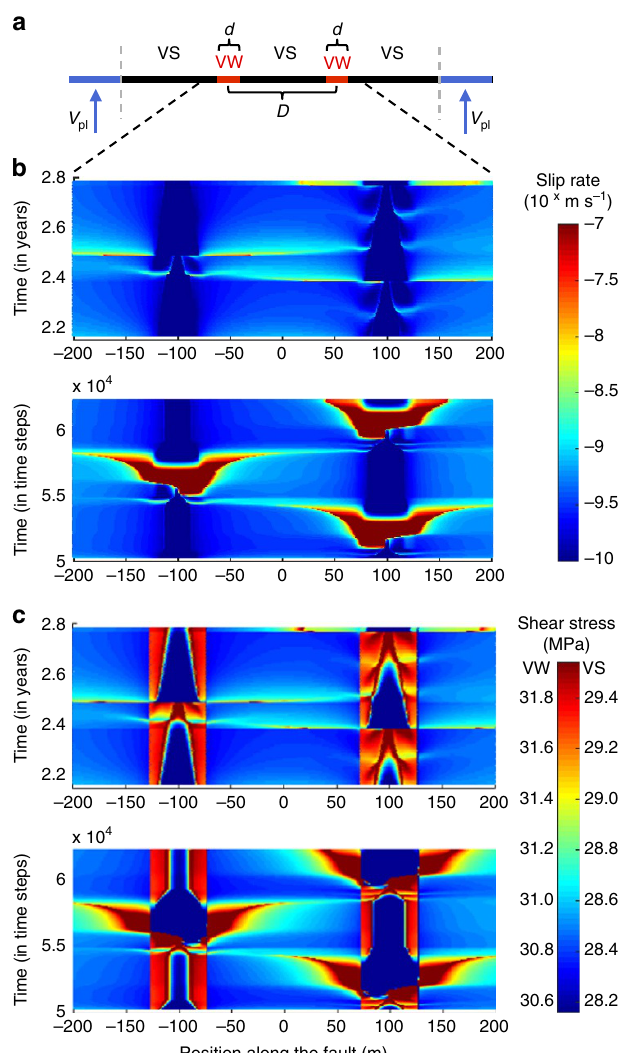
Figure 1 | Interaction of two repeating earthquake sequences in a rate- and-state fault model. ( a ) Schematics of the model in which a one- dimensional fault is embedded into elastic medium and loaded with slow, tectonic slip rate ( V pl )of 23mm per year. The fault contains two seismogenic VW patches surrounded with VS regions. D is the separation distance between the centre of the two VW patches and d is the diameter of each patch. ( b , c ) Evolution of slip rate ( b ) and shear stress ( c ) on the fault with the simulated time (top) and as functions of variable time step (bottom). The colour scales are chosen to emphasize the slip rates and stress values relevant to postseismic effects. Seismic events start at an edge of a VW patch and spread through the patch, penetrating into and eventually stopping in the surrounding VS regions. The resulting postseismic creeping fronts (PCFs) are clearly observed travelling from one patch to the other. The PCF from the right patch advances the seismic event on the left patch. The PCF from the left patch triggers some aseismic slip on the right patch, but without changing the timing of the event appreciably. The time-dependent evolution of the slip rate is also shown in Supplementary Movie